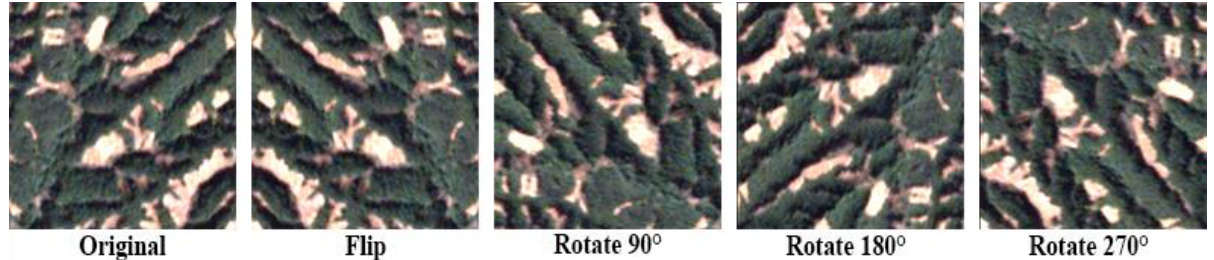
Figure 8. Data augmentation. All samples are augmented by the GDAL library in python, which mainly includes the images flipping, and rotating the images at 90°, 180°, and 270°clockwise.